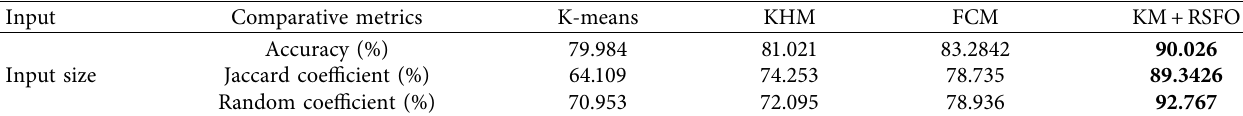
Table 1: Comparative result analysis